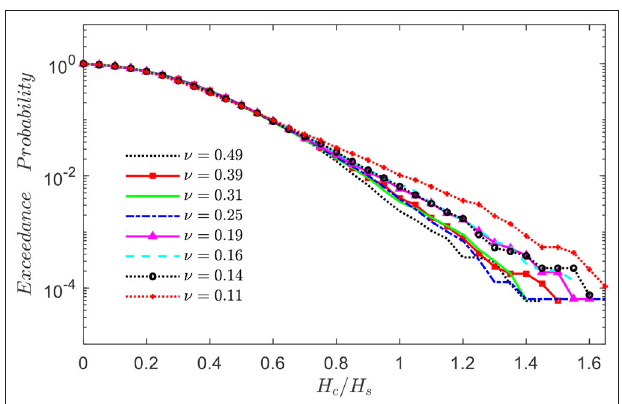
FIGURE 6 | Wave crest exceedance probability estimated by using fully non-linear numerical results.